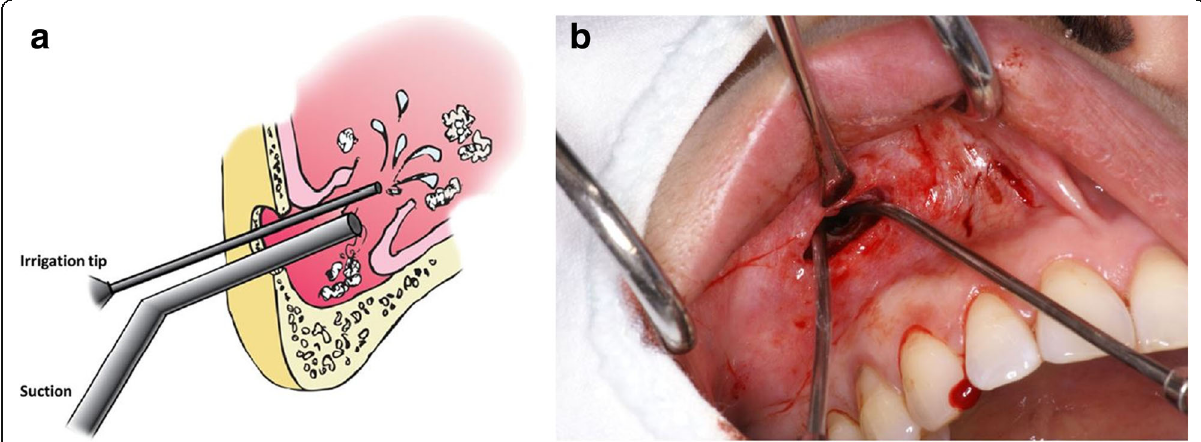
Fig. 2 a Illustration depicting how the infected graft materials are being irrigated and suctioned through an anthrostomy window of the anterior wall of the sinus. b Irrigation and suction through an anthrostomy window of the anterior wall of the